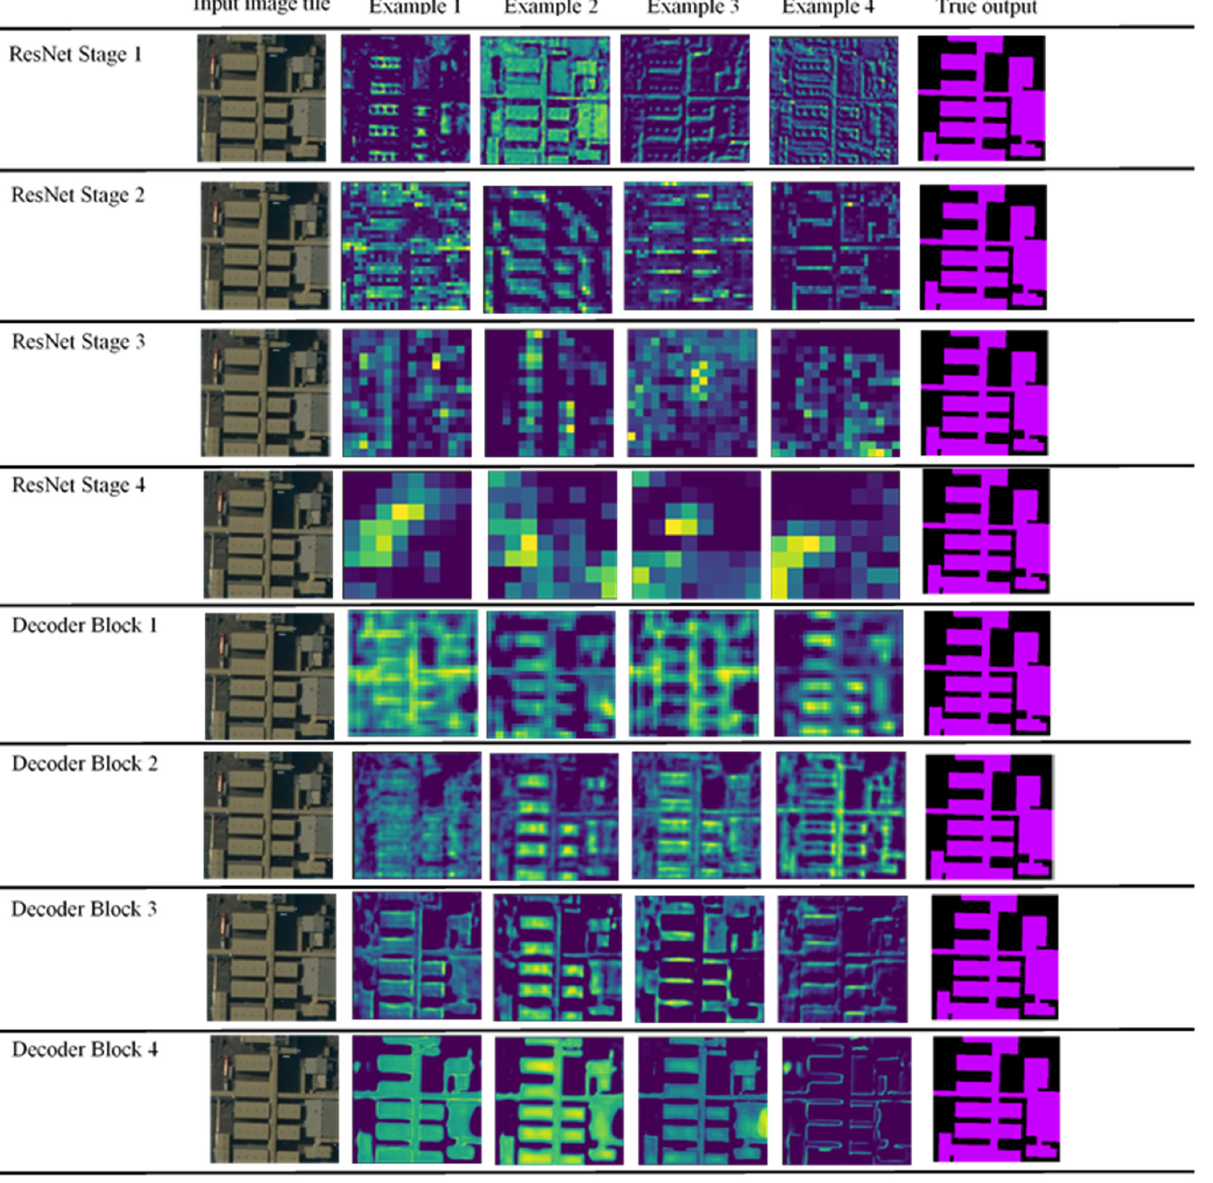
Figure 11. Four selected CFMs (Columns 2–5) from the final layer of each ResNet-50 backbone stage and decoder block. First column contains the input image tile, and final column contains the true output. Each feature map visualizes features learned by the model in detection of industrial buildings. Imagery © DigitalGlobe, Inc.